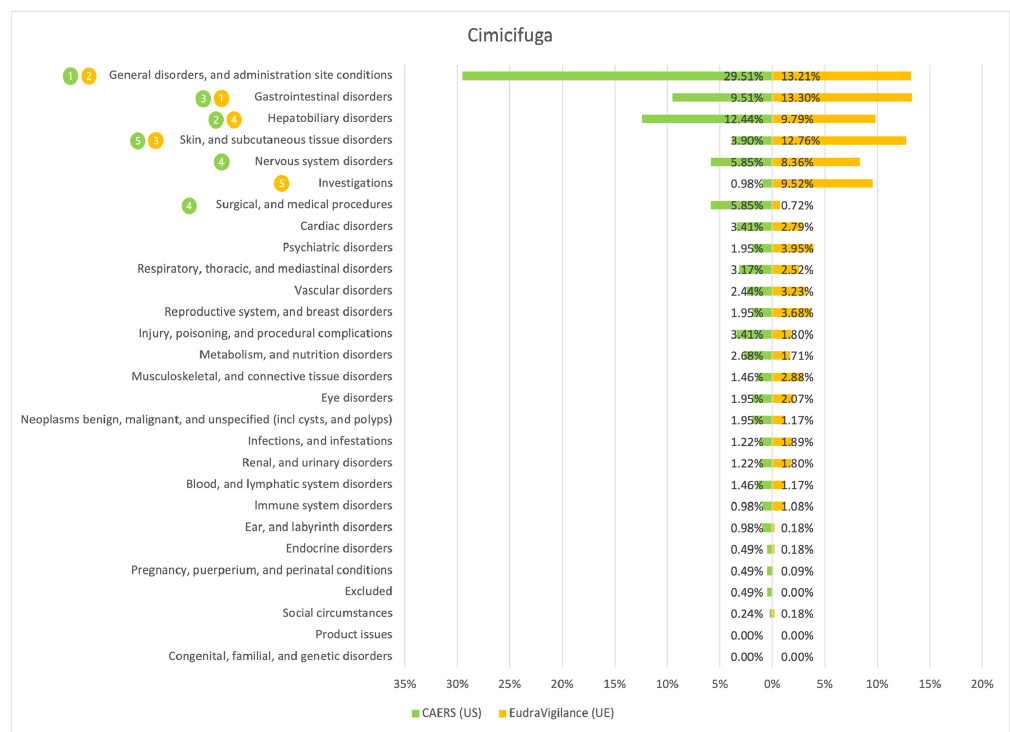
Figure 7. Summary of the frequency of reporting side effects of Cimicifuga in the US and EU registers. Data marked in green refer to the CAERS (US) database and yellow to the EudraVigilance (UE) database. Numbers 1–5 present the most commonly reported categories of adverse effects in descending order.